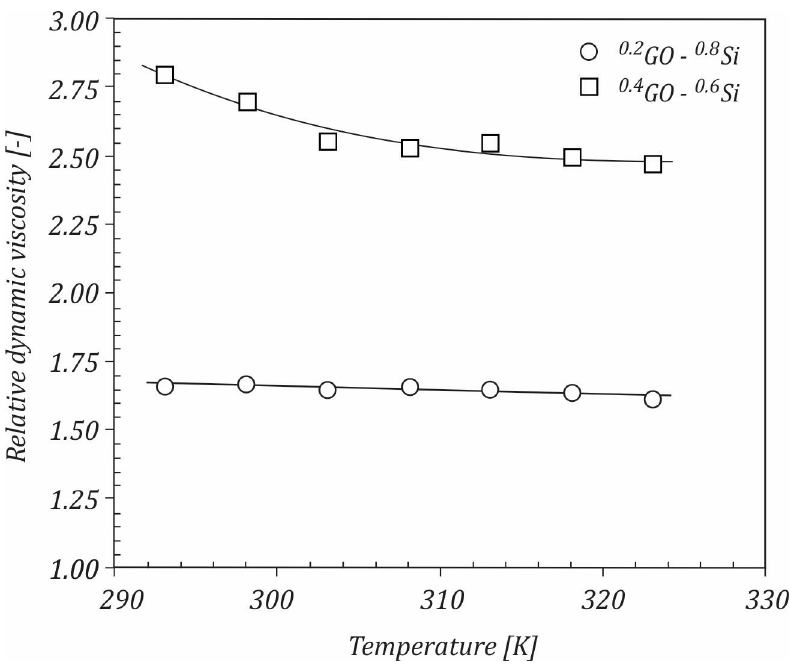
Figure 7. Variation of relative dynamic viscosity with temperature.